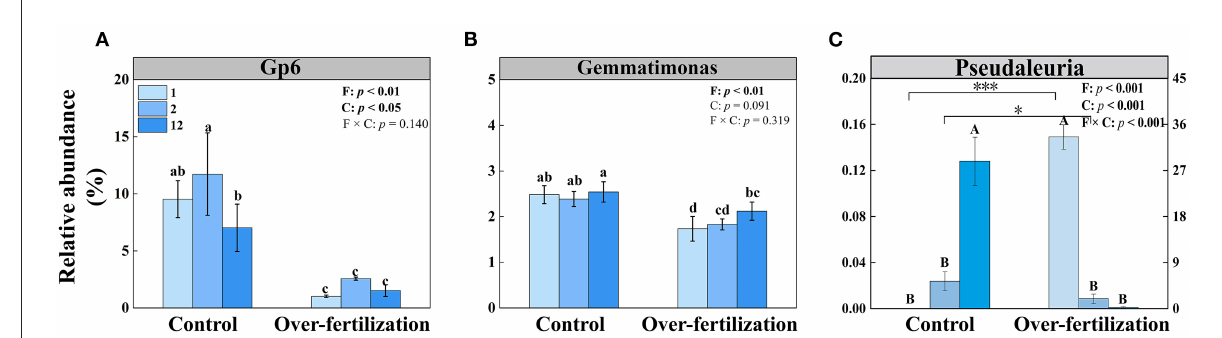
FIGURE5 Effects of fertilization on the relative abundances of bacteria and fungi under tomato cropping. (A) The relative abundance of Gp6 . (B) The relative abundance of Gemmatimonas . (C) The relative abundance of Pseudaleuria . Values are means ± SD ( n = 3). Different letters (a, b, c, d, and e) above the bars indicate significant ( p < 0.05) differences between all treatments. * and *** indicate significant differences between different fertilization treatments under the same cropping duration at p < 0.05 and p < 0.001, respectively. Different letters (A and B) above the bars indicate significant ( p < 0.05) differences between cropping durations under the same fertilization treatments. F, fertilization; C, cropping